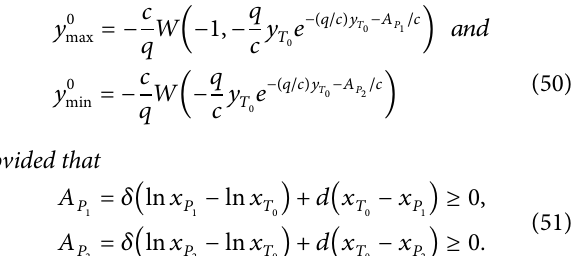
0 , and is a trajectory which is tangent to curve 2 Γ